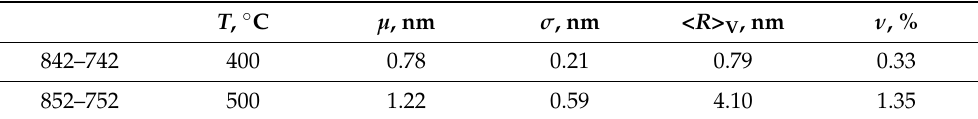
Figure 16. Volume weighted size distribution of Cu nanoparticles as fitted using magnetic SANS. Table 7. Fitted parameters of magnetic